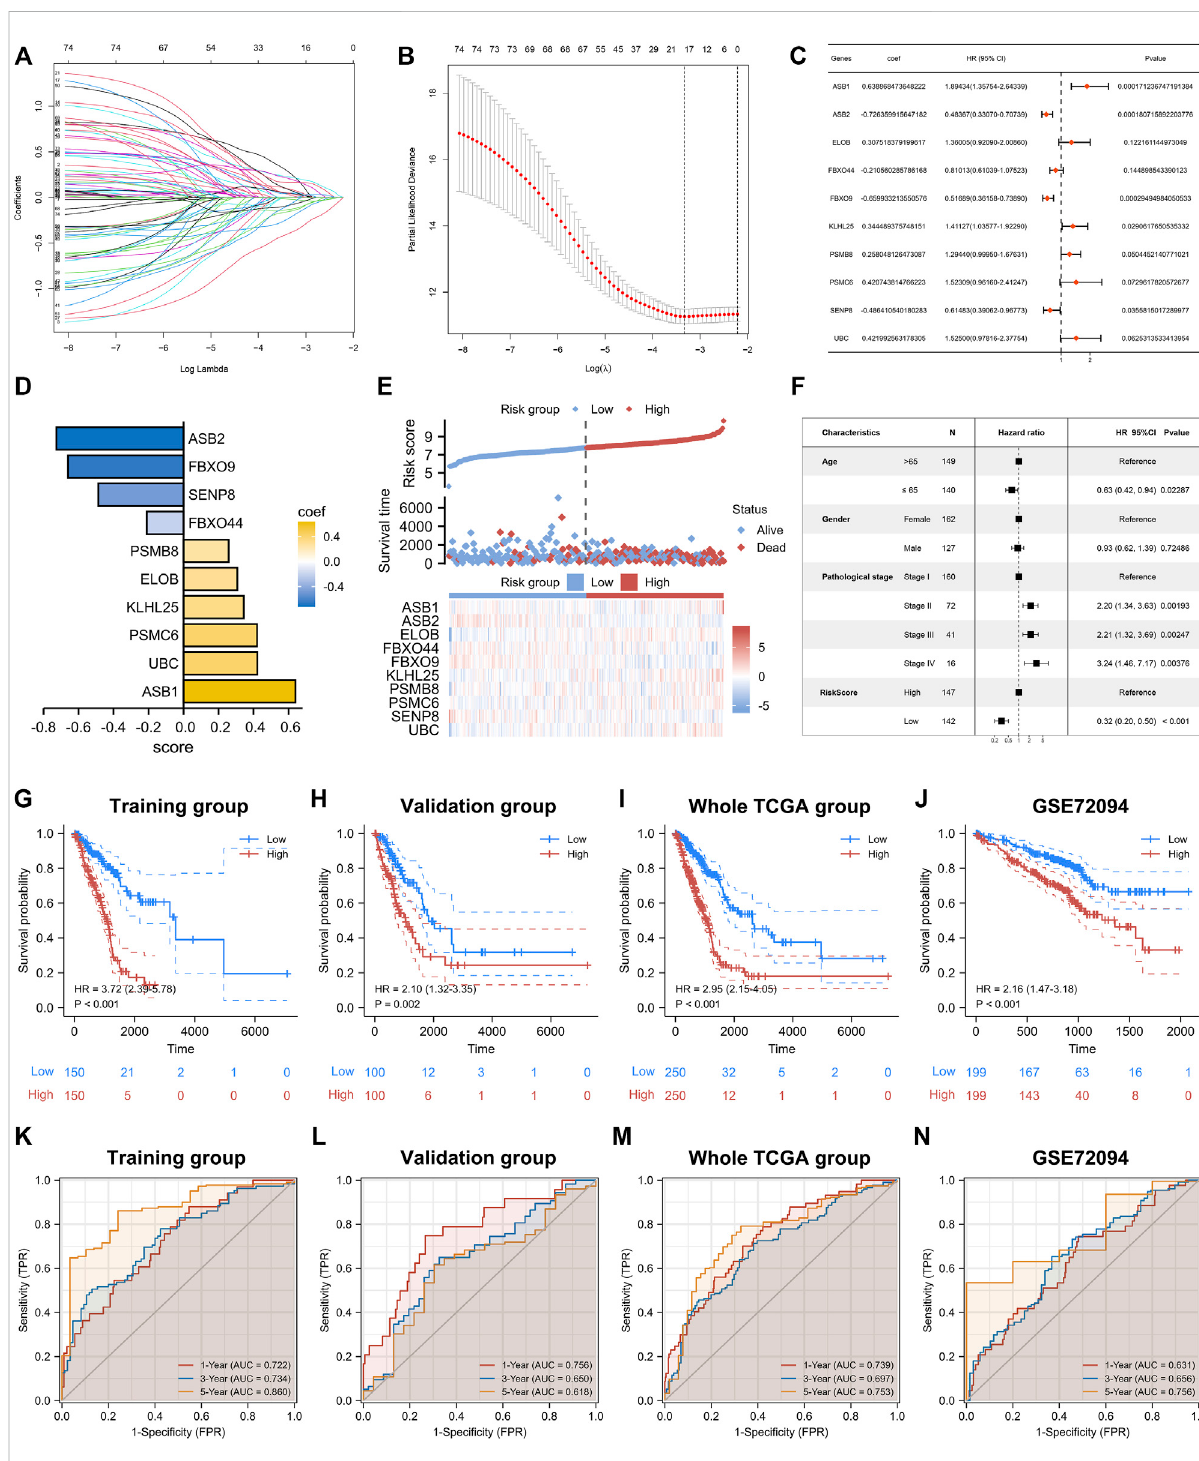
FIGURE 6 Construction of prognostic signature. (A,B) LASSO regression analysis based on 76 prognostic genes. (C) Multivariate Cox analysis was performed on genes obtained from LASSO. (D) The 10 genes that ultimately built the signature. (E) Differences in survival status and expression of 10 genes between high- and low-risk groups. (F) Multivariate Cox analysis of risk score and clinical factors. (G – J) Prognostic analysis of training set, validation set, whole TCGA Set, GSE72094. (K – N) Time-dependent ROC analysis of the training set, validation set, whole TCGA set, and